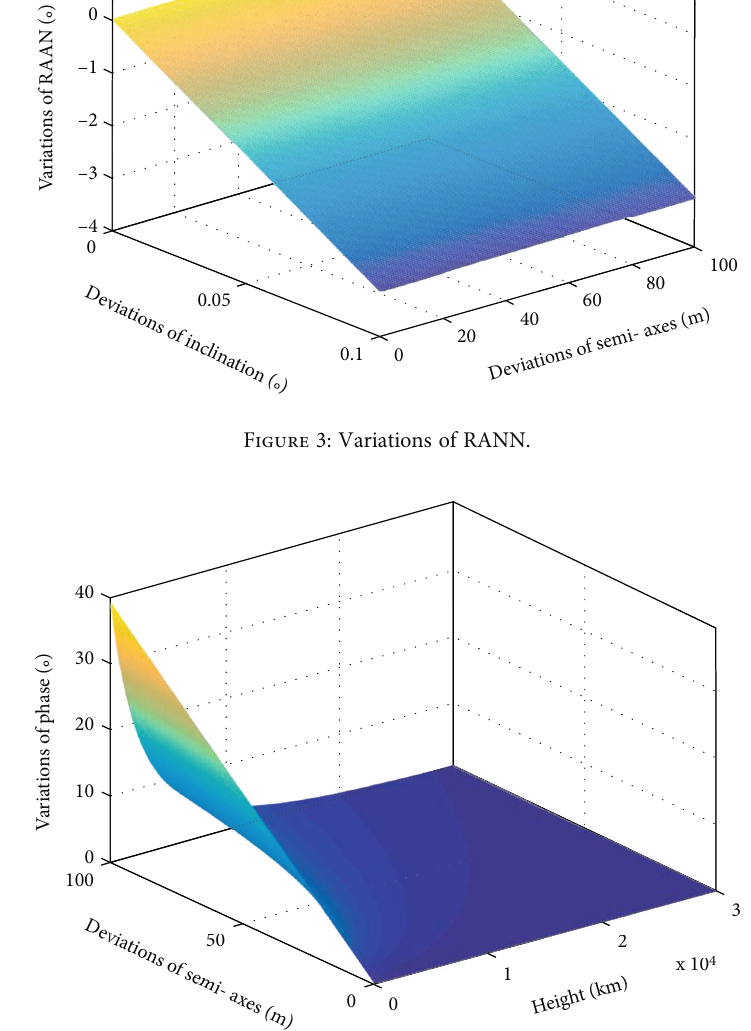
Figure 4: Variations of